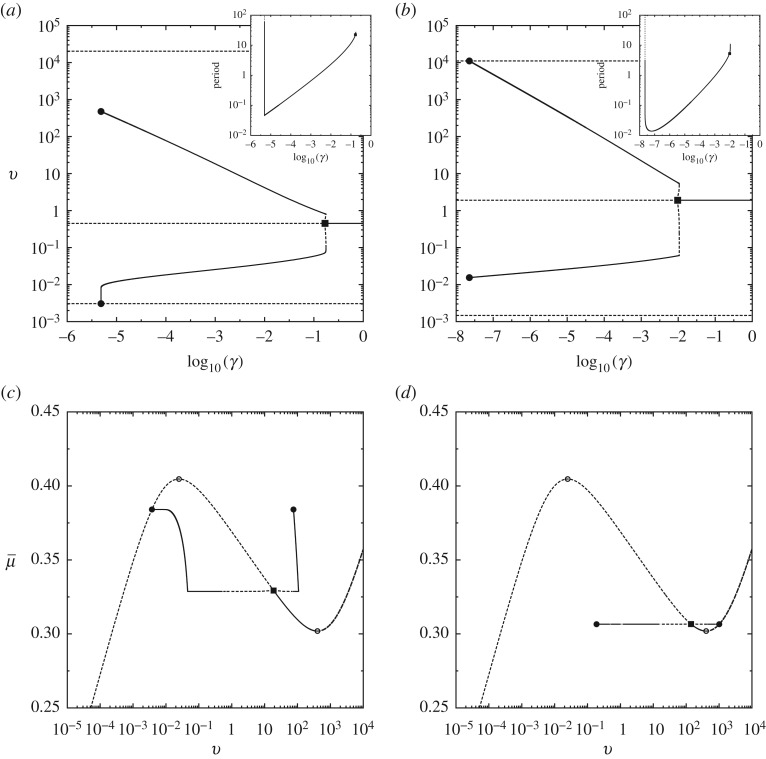
Numerical continuation of wavetrain solutions in γ for fixed μ¯ (a,b) and μ¯ for fixed V (c,d), with the maximum and minimum amplitude super-imposed on the μss versus v curve. In a,c (respectively, b,d) column are typical bifurcation diagrams leading to the slip (respectively, stick) pulse homoclinic orbit. Here the Hopf bifurcation is illustrated via a solid square, folds by hollow circle and homoclinic orbits by a solid circle. Stable and unstable portions of the solution branch are illustrated by solid and dashed lines, respectively. Inserts show the divergence of the period as the homoclinic orbit is approached. (a) μ¯=0.38, (b) μ¯=0.36, (c) V =0.1 and (d) V =0.6.